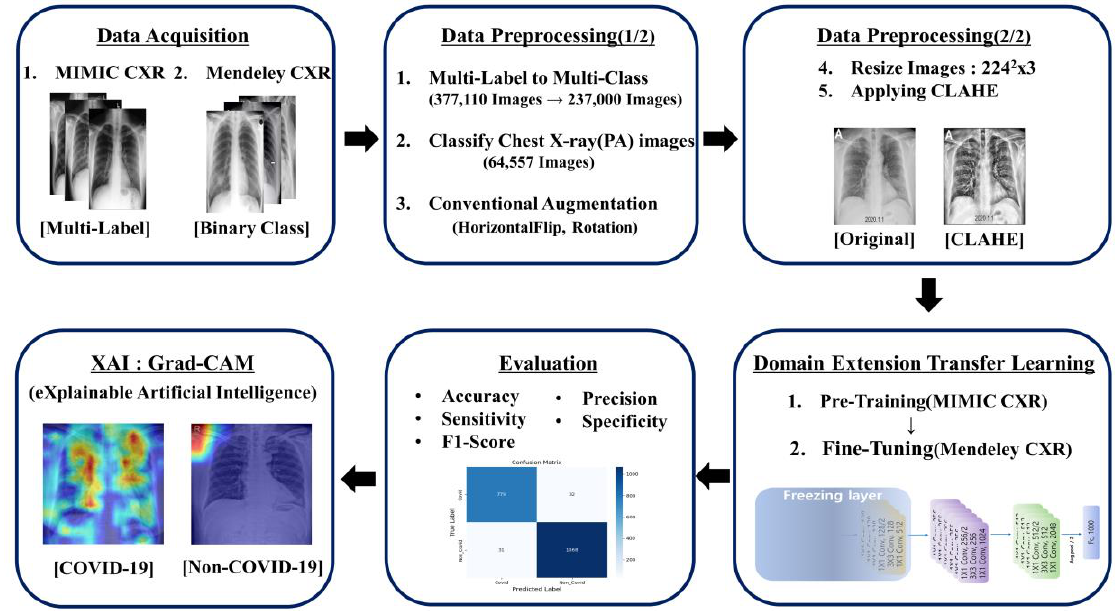
Figure 1. Architecture of the COVID-19 CXR classification framework.